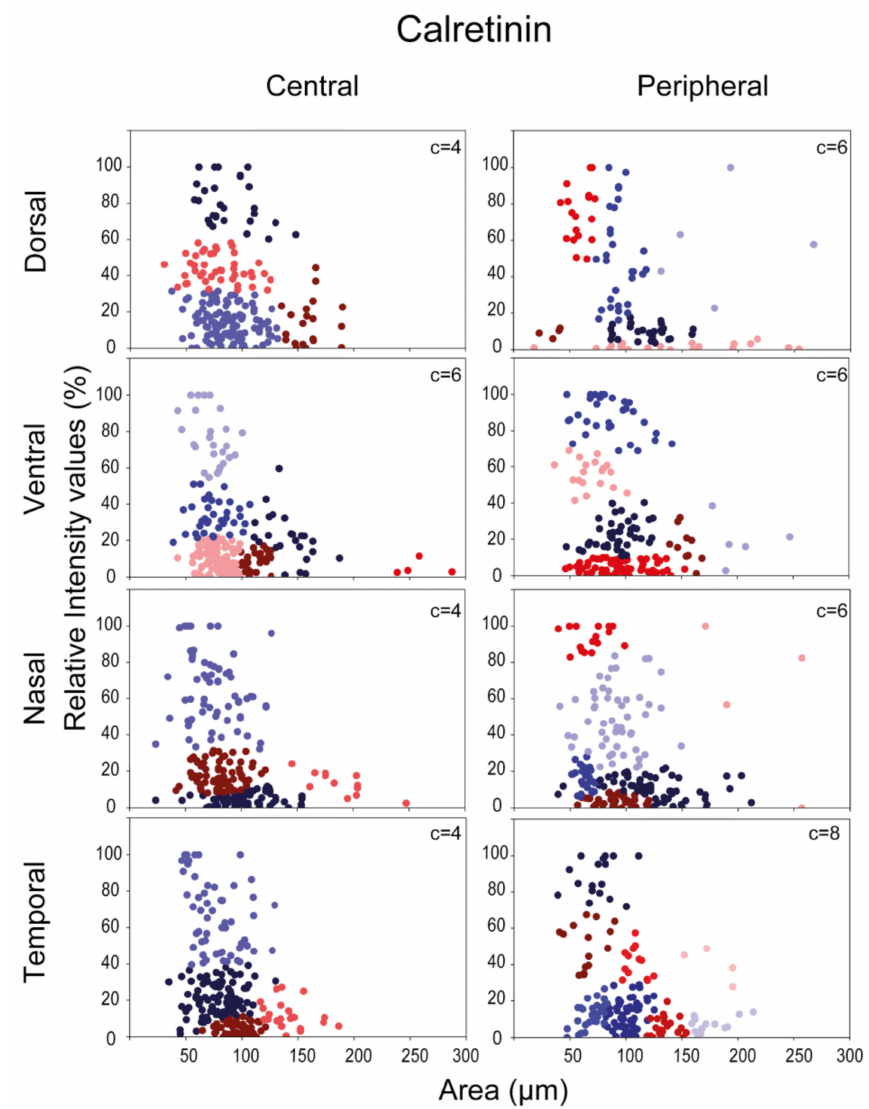
Figure 5. Cluster analysis of CaR expressing RGCs. RGC soma size and CaR expression level were utilized to perform the clustering in both central (left) and peripheral (right) retinal areas separately for each quadrant. Dots indicate individual cells from n = 5 retinas. The clusters of RGCs are color-coded (note that colors do not necessarily represent the same cluster in separate panels). The number of clusters is shown in the top right corner of each